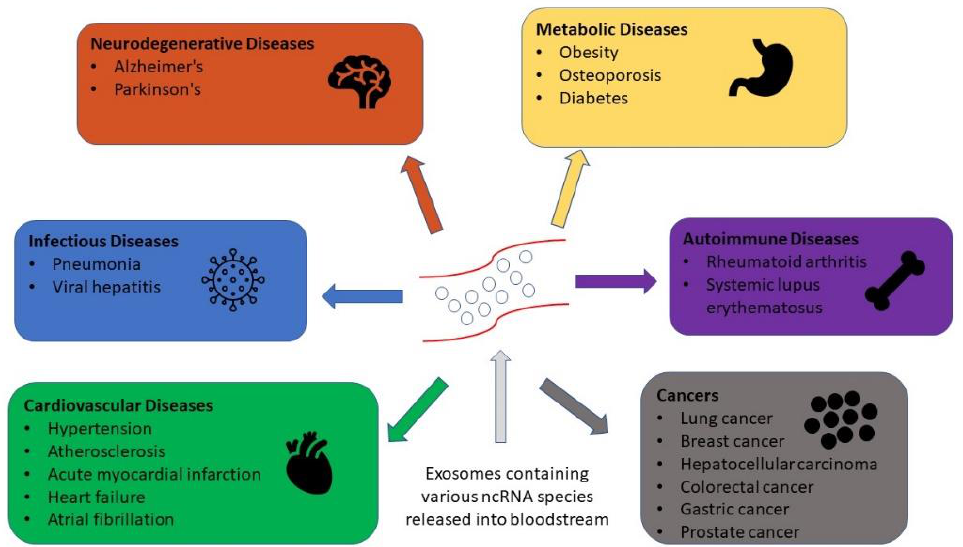
Figure 1. Exosomal ncRNAs in human diseases. Exosomal molecules, including ncRNAs, are dependent on physiological state of the cells they originate from. They are released into the blood stream, allowing them to be utilized as biomarkers of various pathological conditions.